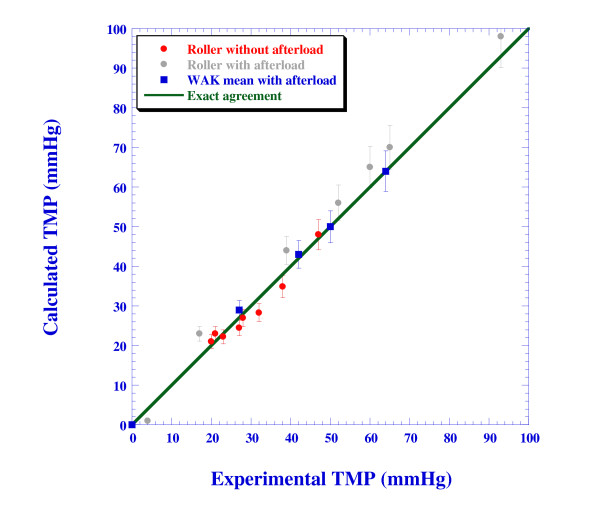
Comparison of the calculated and the experimental TMP.